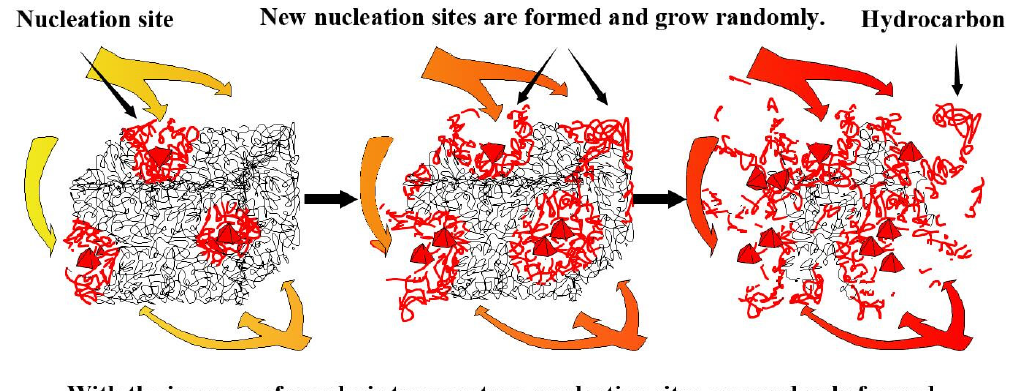
Figure 9. Schematic diagram of the pyrolysis of Reaction II.